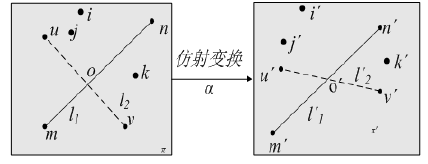
Fig.4 The Affine Invariance of Intersecting Line